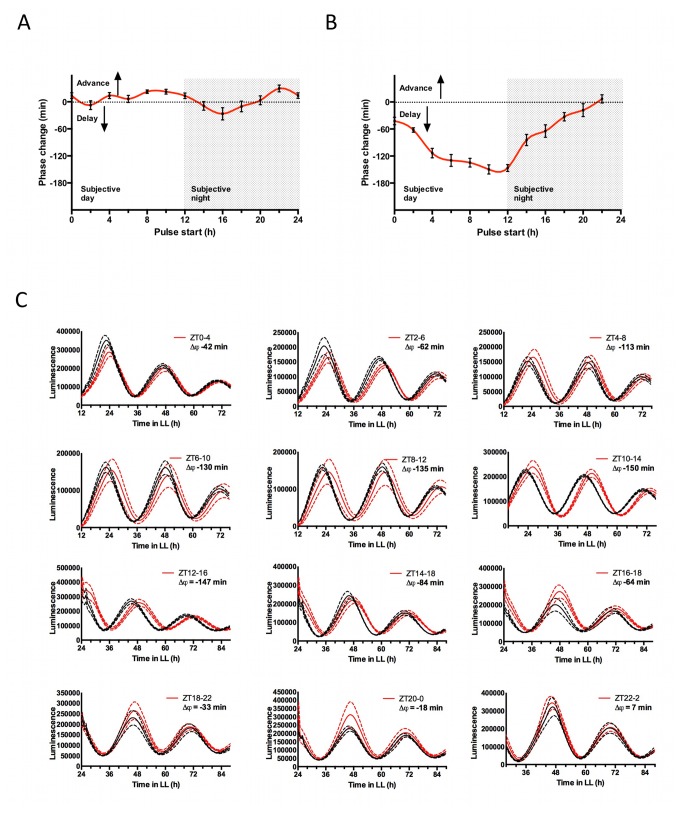
Phase-dependent effect of CK1 inhibition pulses.(A–B) Phase-response curves of CCA1-LUC cells to 4-hour treatment pulses with 10 µM CK1 inhibitor IC261 (A) or 4 µM PF-670462 (B). The start time of the pulse (hours after transfer to constant light) is plotted against the phase change of reinitiated circadian rhythms observed upon wash-off of the inhibitor, compared to vehicle-treated cells (n=8). (C) Traces of rhythms appearing after vehicle treatments (black traces) versus PF-670462-treated cells (red), for all treatments. Dotted lines indicate SD (n=8). Treatment times (in ZT) are provided, along with approximate average phase change (Δϕ) in minutes. Phase delays are negative values by consensus.